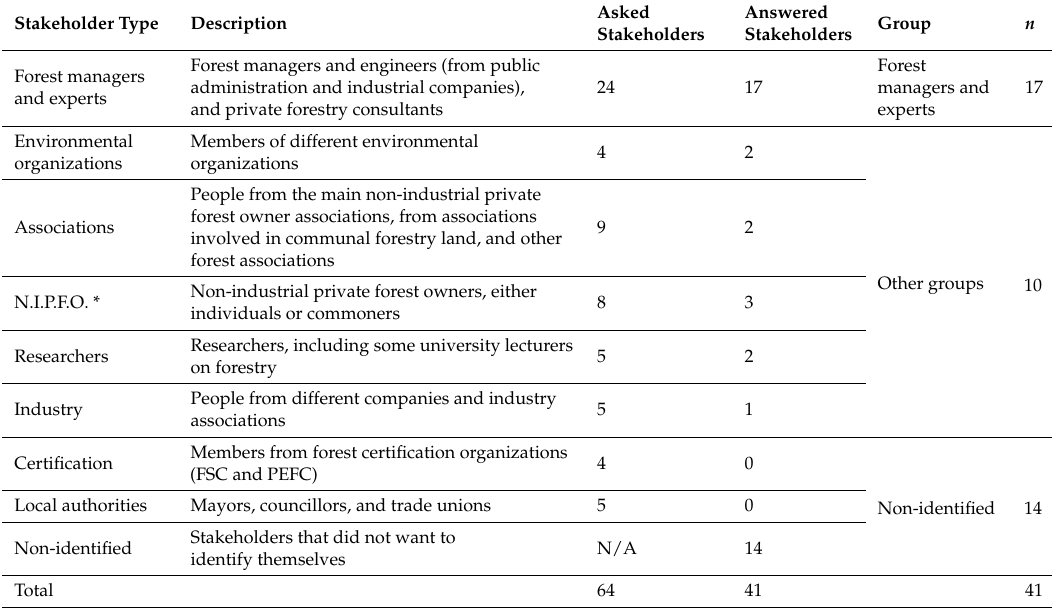
Table 1. Stakeholders and stakeholders groups considered in this